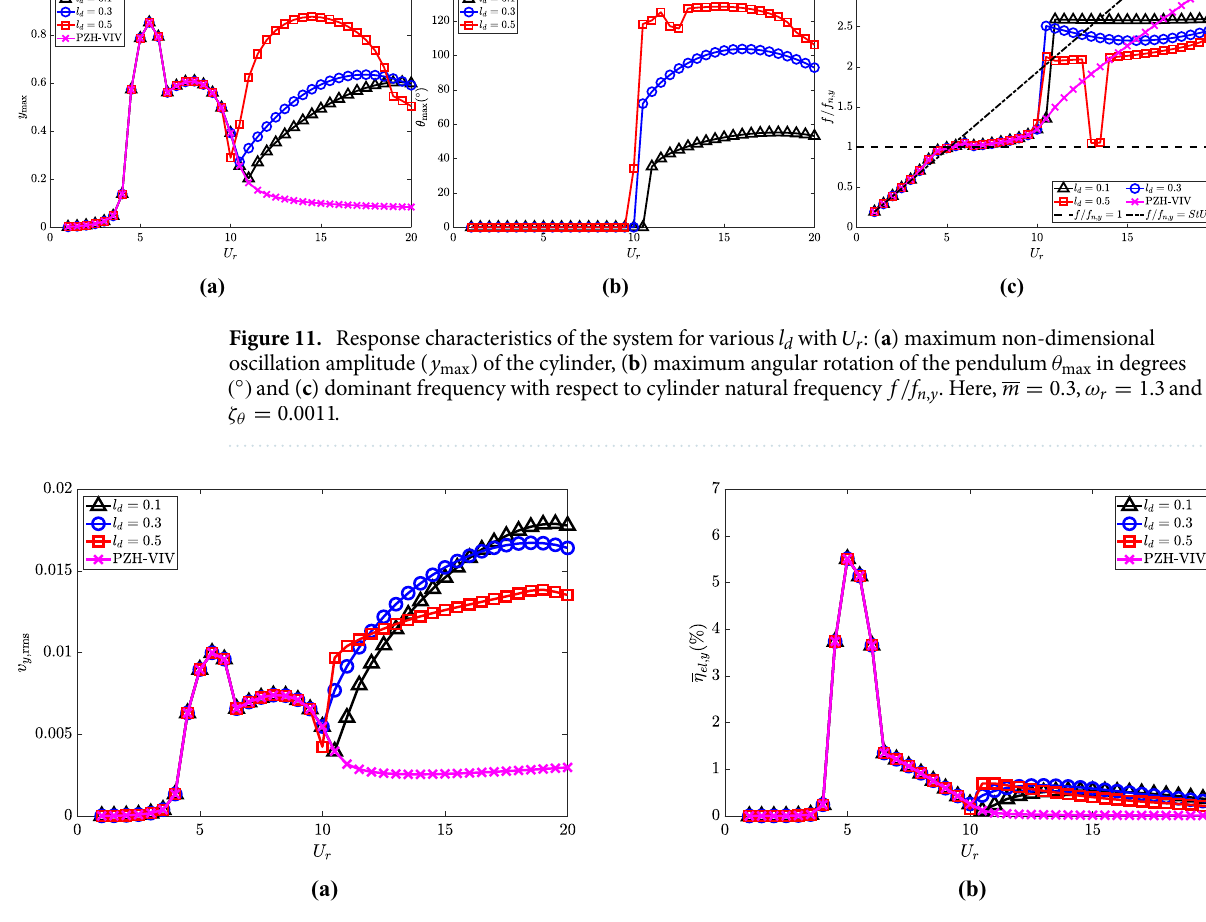
Figure 12. Effect of l d in the introduction of NRGP with U r on: ( a ) electric tension v y ,rms , and ( b ) energy harvesting efficiency η el , y . Here, m = 0.3 , ω r = 1.3 and ζ θ = 0.0011